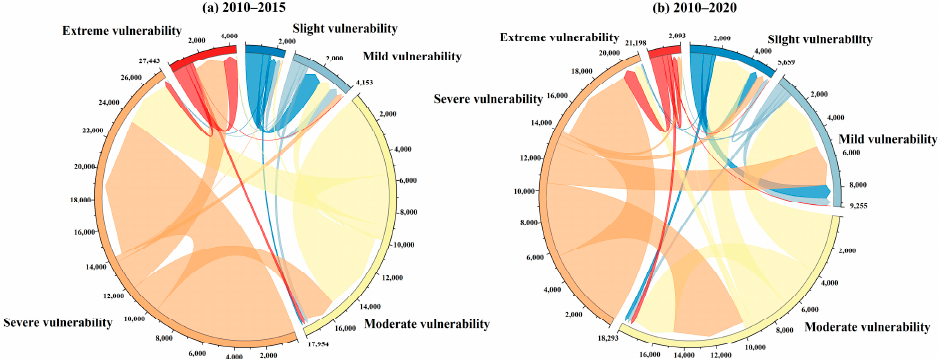
Figure 3. Dynamics change in ecological vulnerability categories for the Nansi Lake Basin during 2010-2015 ( a ) and 2010-2020 ( b ).